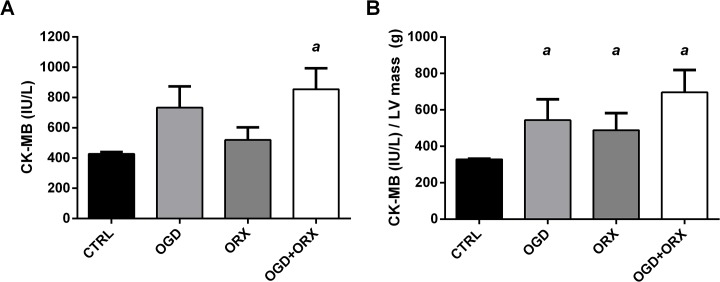
Cardiac-specific Creatine Kinase (CK-MB) levels.(A) Serum concentration. (B) Serum concentration expressed relative to left ventricular (LV) mass. CTRL–control, OGD–obesogenic diet-fed, ORX–orchiectomised. Letters denote significant differences between respective groups, p<0.05 (a vs. CTRL, b vs. OGD, c vs. ORX).